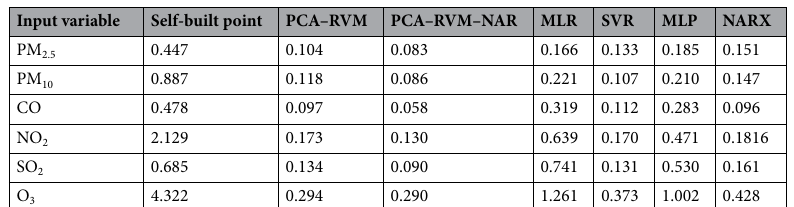
Table 5. The MAE of self-built point and various air quality prediction models, in which national control point is used as comparison object.